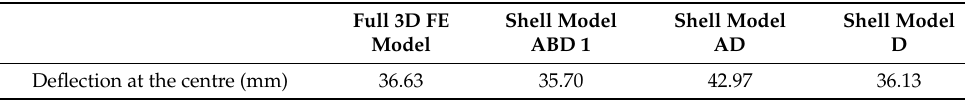
Table 5. The deflection at the mid-span computed using the full 3D model (Type-D) and three simplified shell models (based on RVE-1 homogenization FE model).